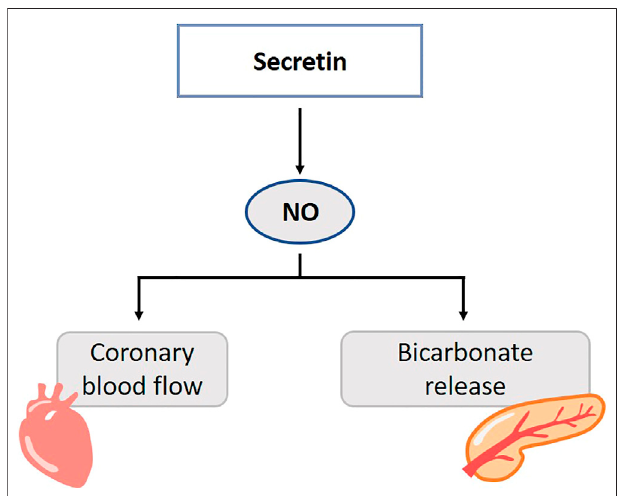
FIGURE 6 | Role of gasotransmitters on secretin ’ s physiological functions. Solid lines are clear evidence – based on blockers and substrate administration. NO mediates the action of secretin on the exocrine pancreas. Release of NO is involved in the secretin-induced increase in coronary blood fl ow. NO, Nitric